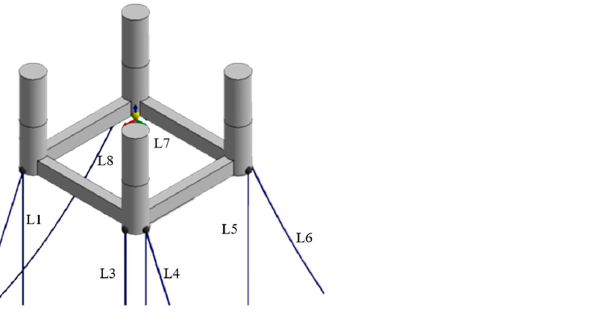
Figure 7. 3D view of inclined tension legs. (The tension legs of the TLP are numbered from L1 to L8 counterclockwise, where L2, L4, L6 and L8 are tension legs with an inclined angle of 30°.)